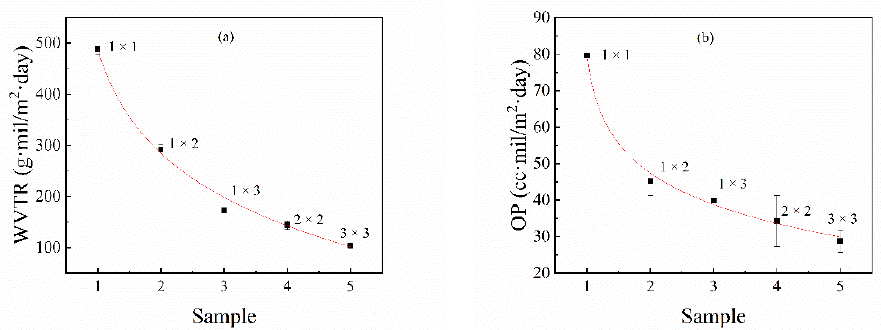
Figure 12. The effect on the barrier properties of PA510/SiO 2 films: ( a ) water vapor permeability (WVP) and ( b ) oxygen permeability (OP).